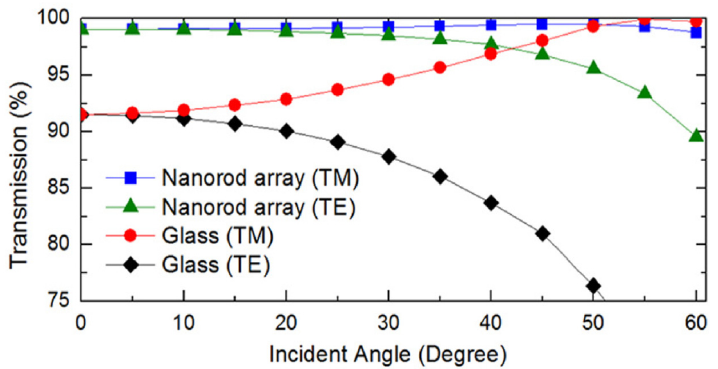
Figure 16. Angle of incidence FDTD simulations for nanorod arrays in TE and TM polarization [47]. Reprinted with permission from reference [47], Copyright 2011 AIP